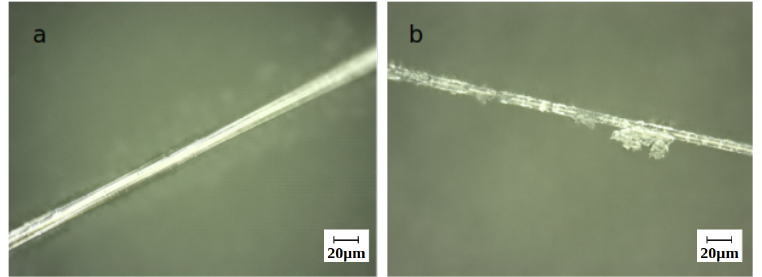
Figure 9. Microscope images of the glass SB fiber ( a ) and SB-MMT fiber ( b ) after immersion in cement solution